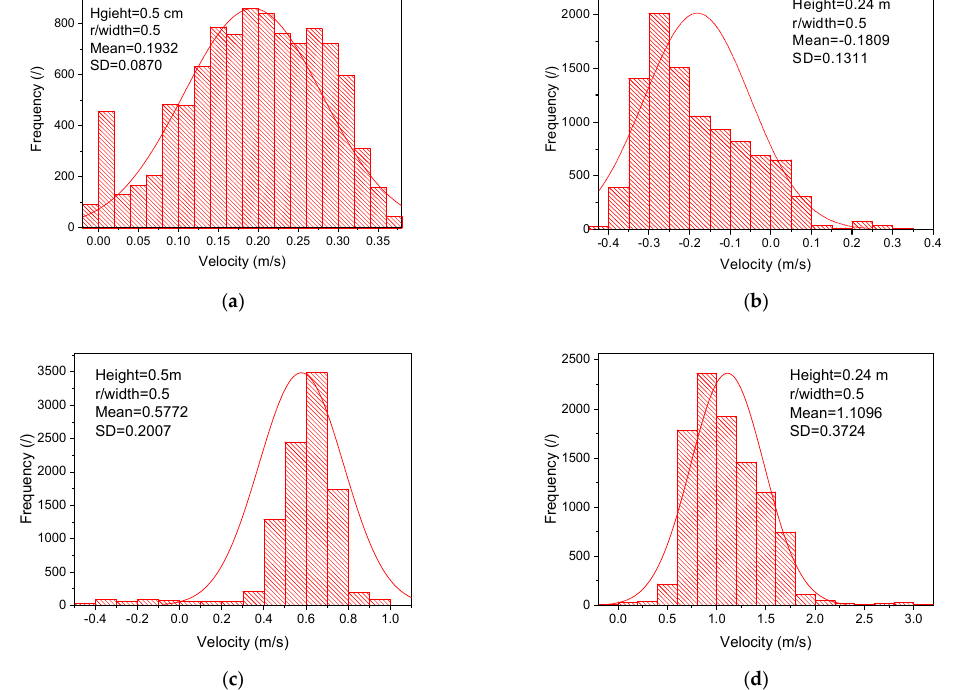
Figure 8. Histograms of central axial and lateral velocities of particles used in experiment at the height of 0.24 m and 0.5 m, r/Width = 0.5, ρ p = 2700 kg/m 3 . ( a ) lateral velocity, 0.5 m; ( b ) lateral velocity, 0.24 m; ( c ) axial velocity, 0.5 m; ( d ) axial velocity, 0.24 m.